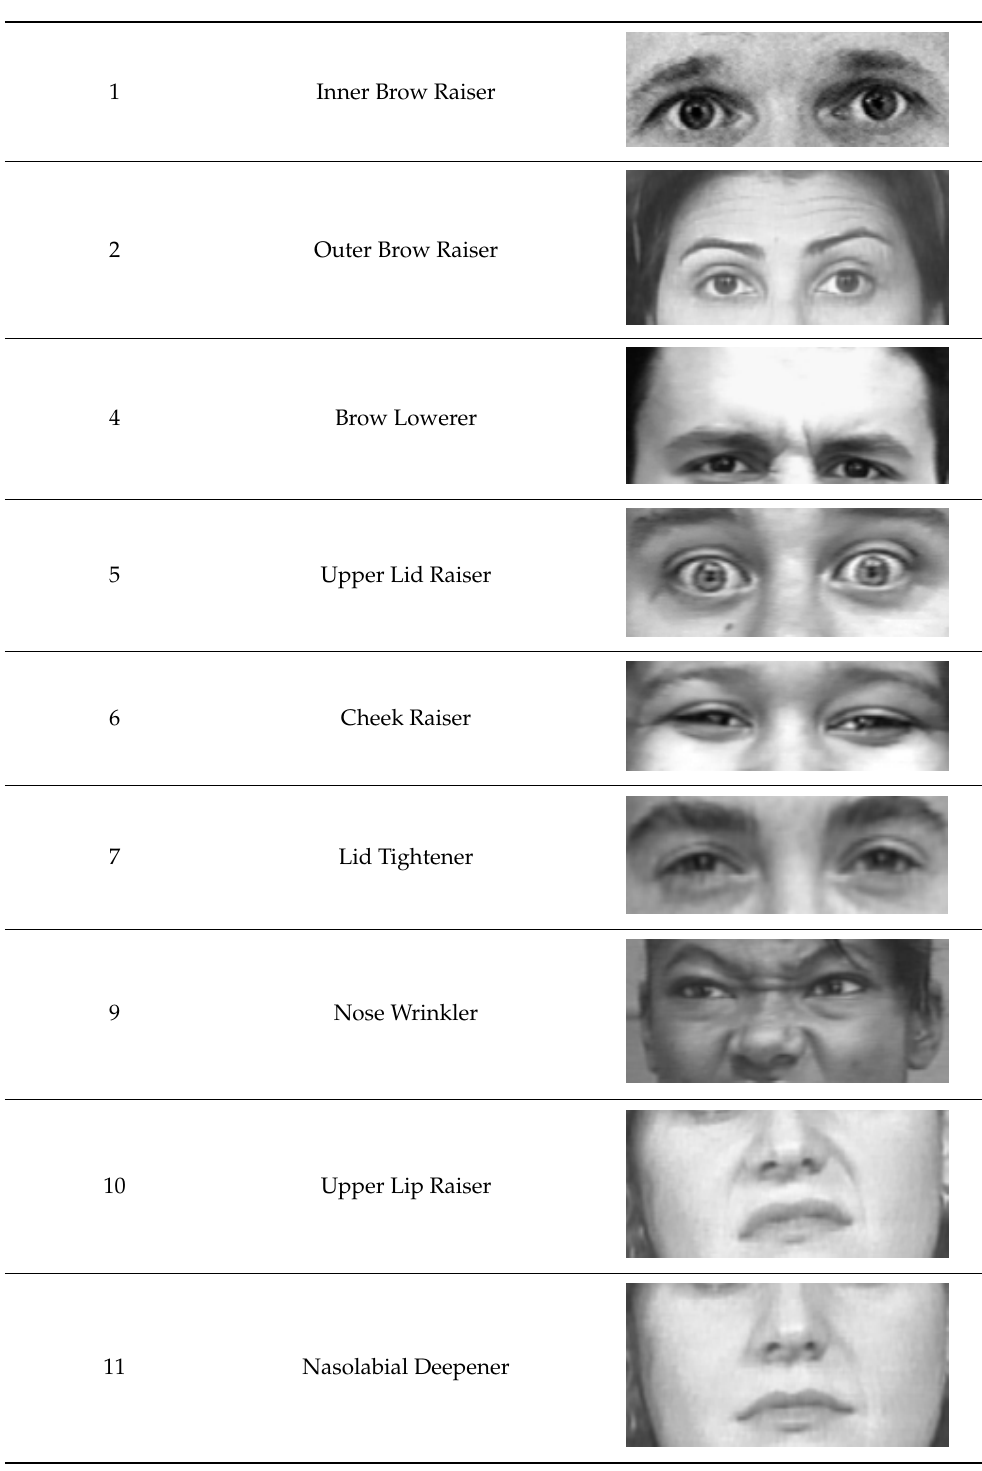
Figure 4. Action units Table 3. Action units.